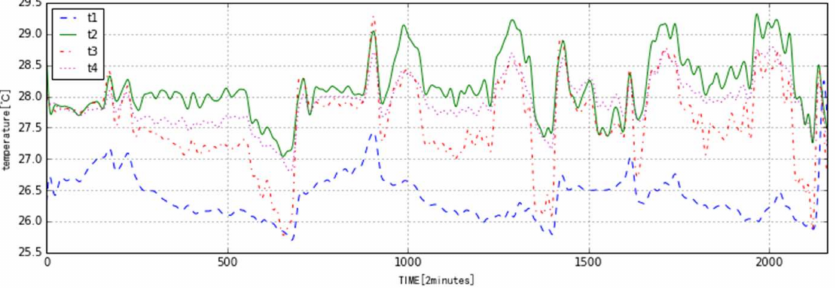
Figure 3. Processed temperature data.